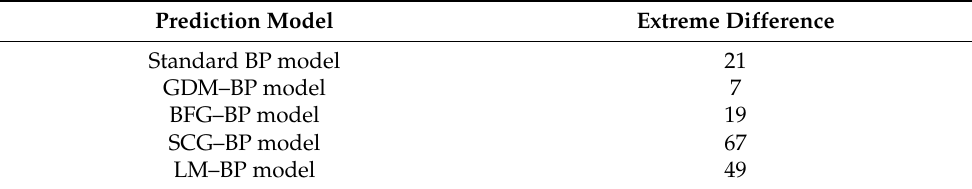
Table 4. Extreme difference values of C for different dimensionless methods under the same model.